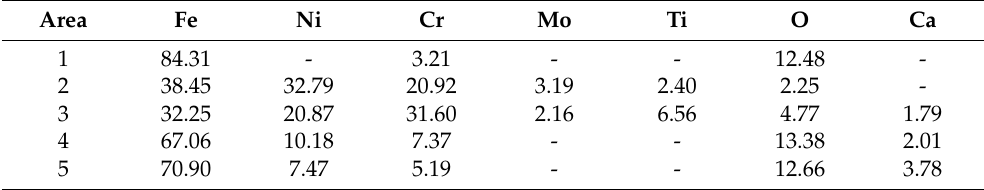
Table 2. The EDS analysis results of different area from the wear surface